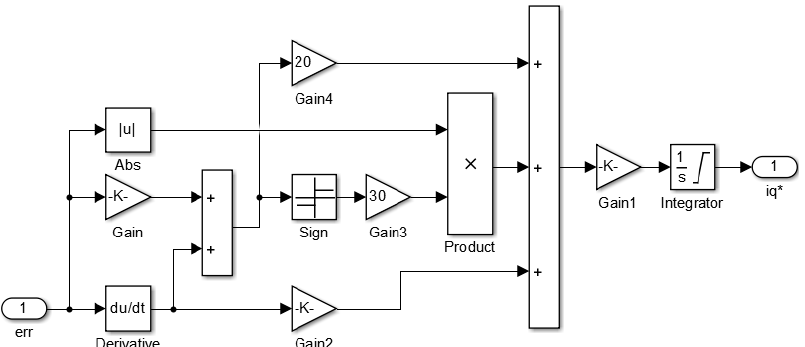
Figure 3. Configuration of the sliding mode controller.